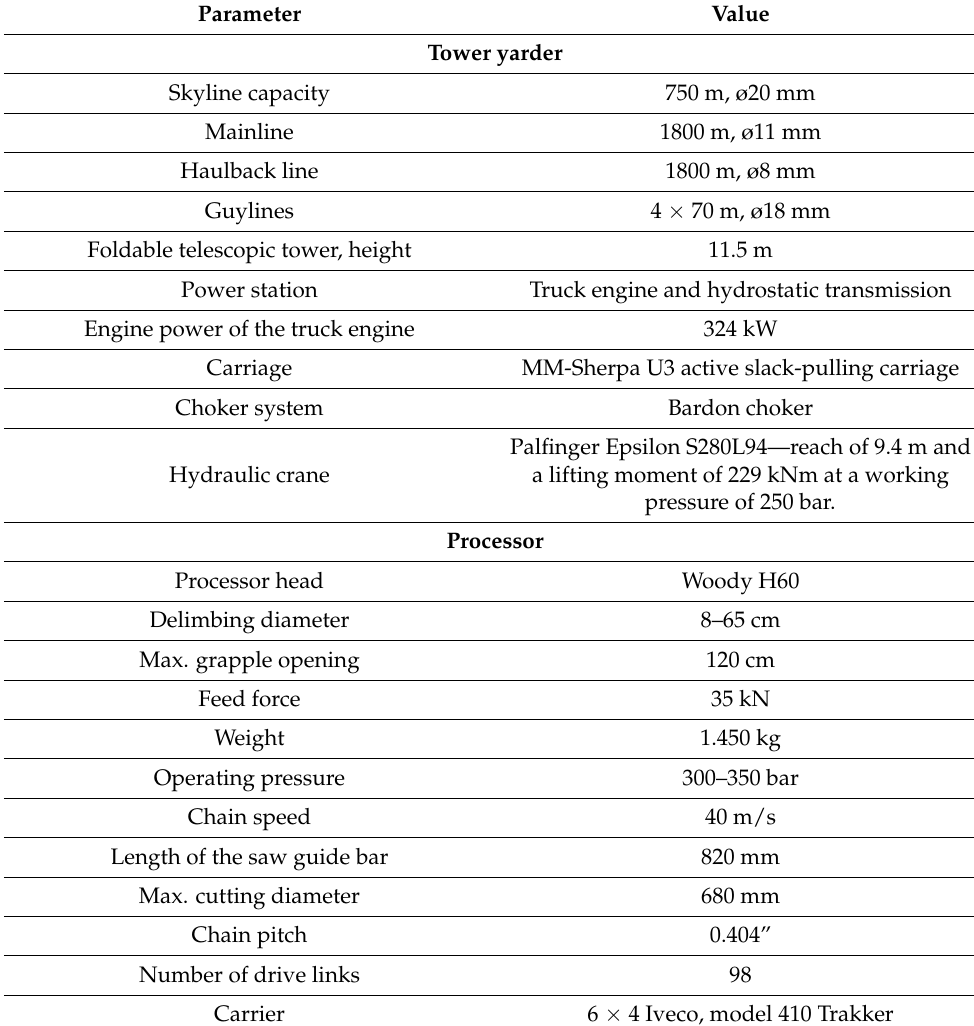
Table 2. Technical data of the studied Syncrofalke 3t processor tower